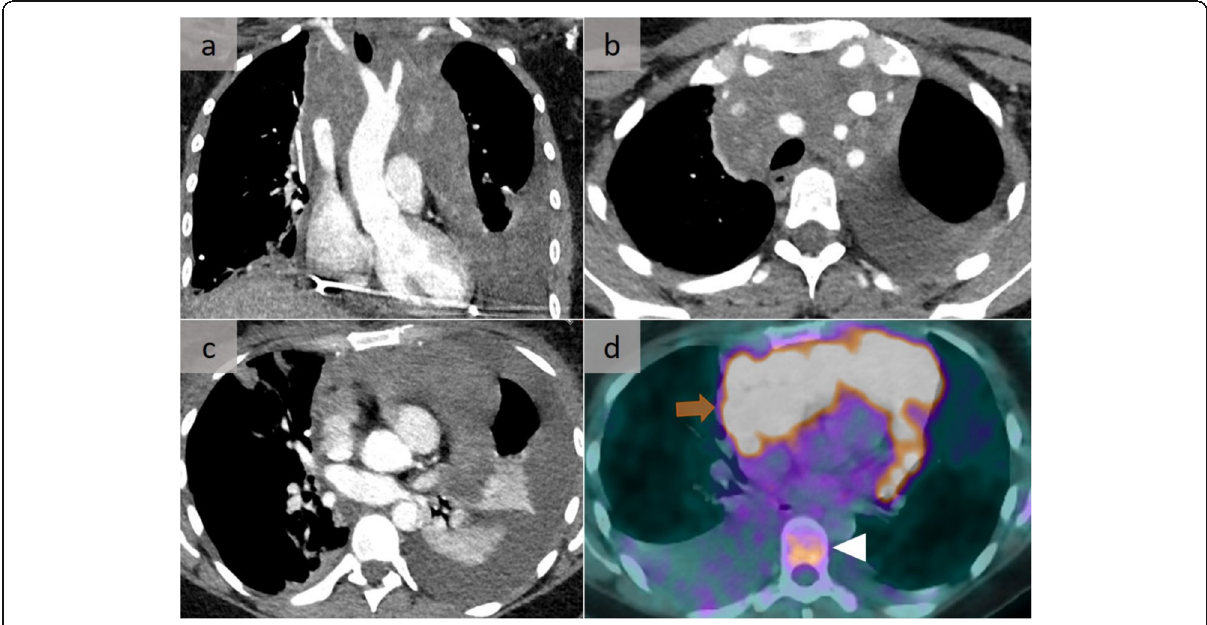
Fig. 13 Hodgkin ’ s lymphoma. Diffuse mediastinal involvement well demonstrated on a coronal ( a ) and two successive axial slices ( a , b ). There is a contiguous pericardial involvement ( c ), with increased metabolic activity on the 18F-FDG PET-CT ( d ) (arrow). Note also the increased metabolic activity of the D11 vertebrae, suspicious for bone involvement (arrowhead), the partial resolution of the left pleural effusion following drainage, as well as a new right pleural